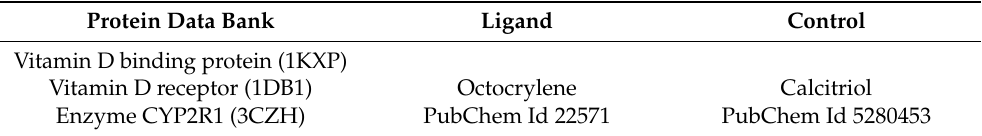
Table 5. Information about the protein and ligands used in the study. Protein Data